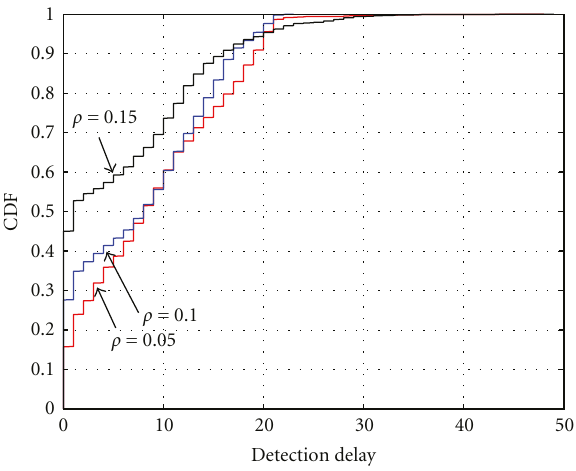
Figure 8: CDF of detection delay for ρ = 0 . 05,0 . 1,0 . 15 when approximate DP is used.